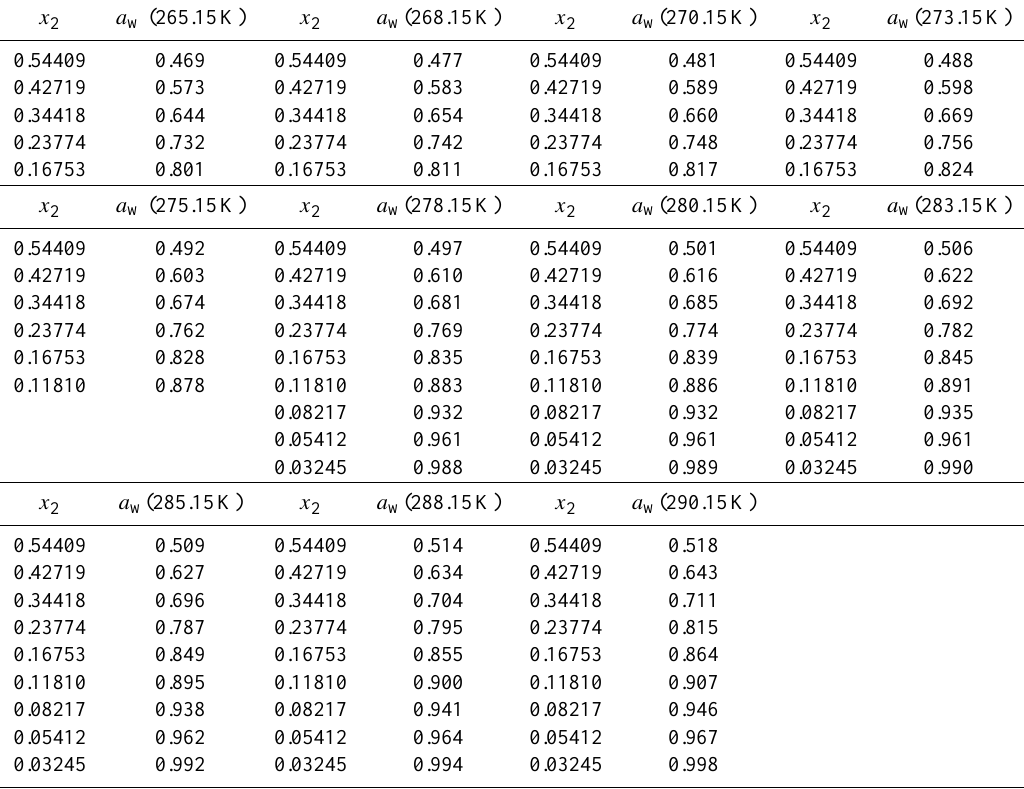
Table 14. Measured water activities of water (1) + 2-(2-ethoxyethoxy)ethanol (2) mixtures derived from total gas phase pressure measure- ments ∗ , listed for a selection of temperatures in the range 265K <T < 291K. Solution compositions are given in mole fractions of the organic (x 2 ) .